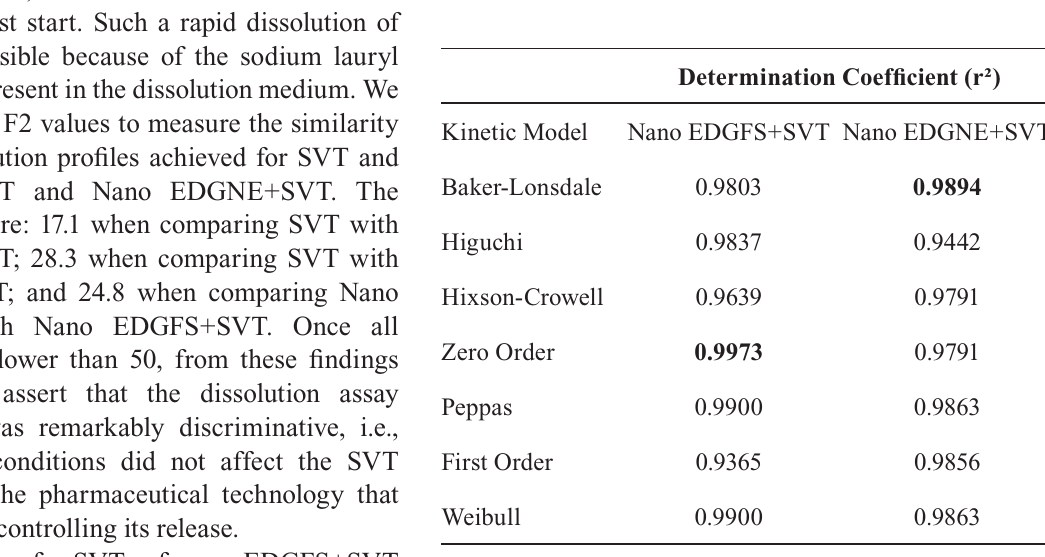
TABLE III - Mathematical models and their determination coefficients (r²) used to characterize release kinetics of simvastatin from Eudragit ® polymeric nanoparticles